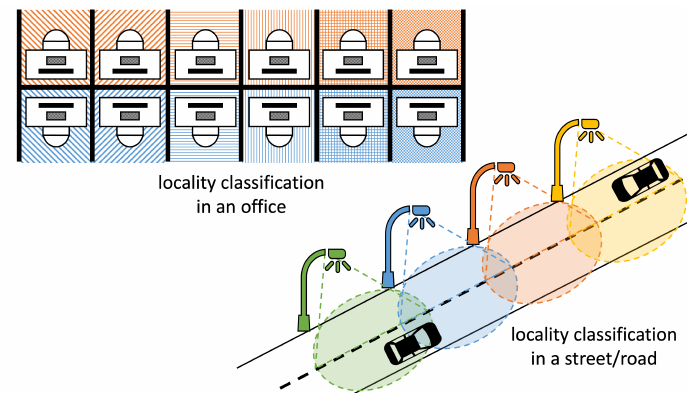
Figure 7. Examples of locality classification systems.